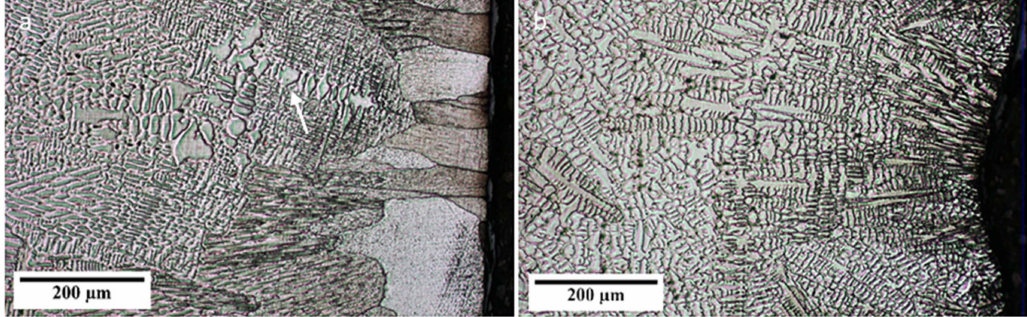
Figure 5. Structure of the surface region in sample 11, showing ( a ) a coarse grain next to a fine surface structure and ( b ) a coarse surface